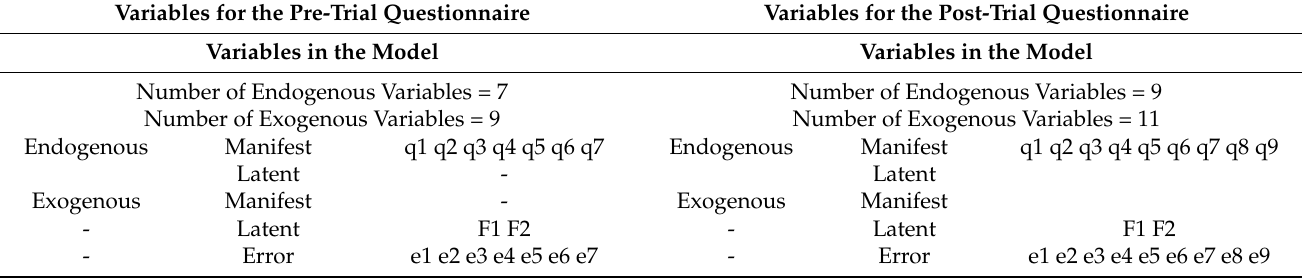
Table 4. Variables information.